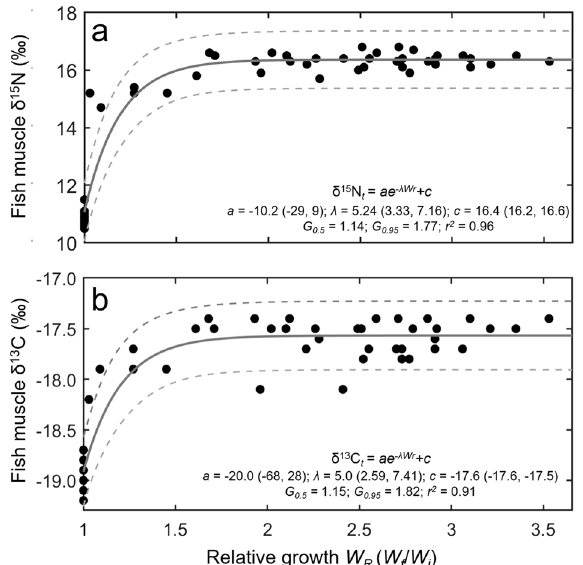
Figure 4. Isotopic change with fish growth for ( a ) δ 15 N and ( b ) δ 13 C in captive California yellowtail Seriola dorsalis. Points represent individual measurements and lines show associated model fits (solid lines) and 95% confidence intervals (dashed lines). Model equation and associated parameters (95% confidence intervals) shown for both isotopes. G 0.5 and G 0.95 show the amount of relative growth by mass (mass final /mass initial ) required for 50% turnover and 95% turnover, respectively, of each isotope in yellowtail muscle.